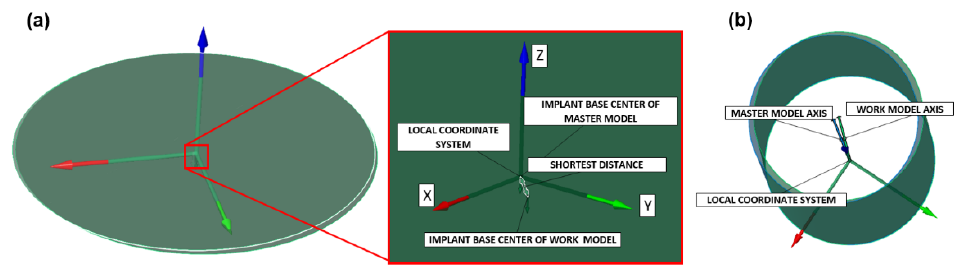
Figure 11. Showing ( a ) measurement of the deviation of the base of the scanned implant and the master model (linear deviation) and ( b ) analysis of the deviation of the scanned implant lateral axis relative to the lateral implant axis (angular deviation) of the master model implant.